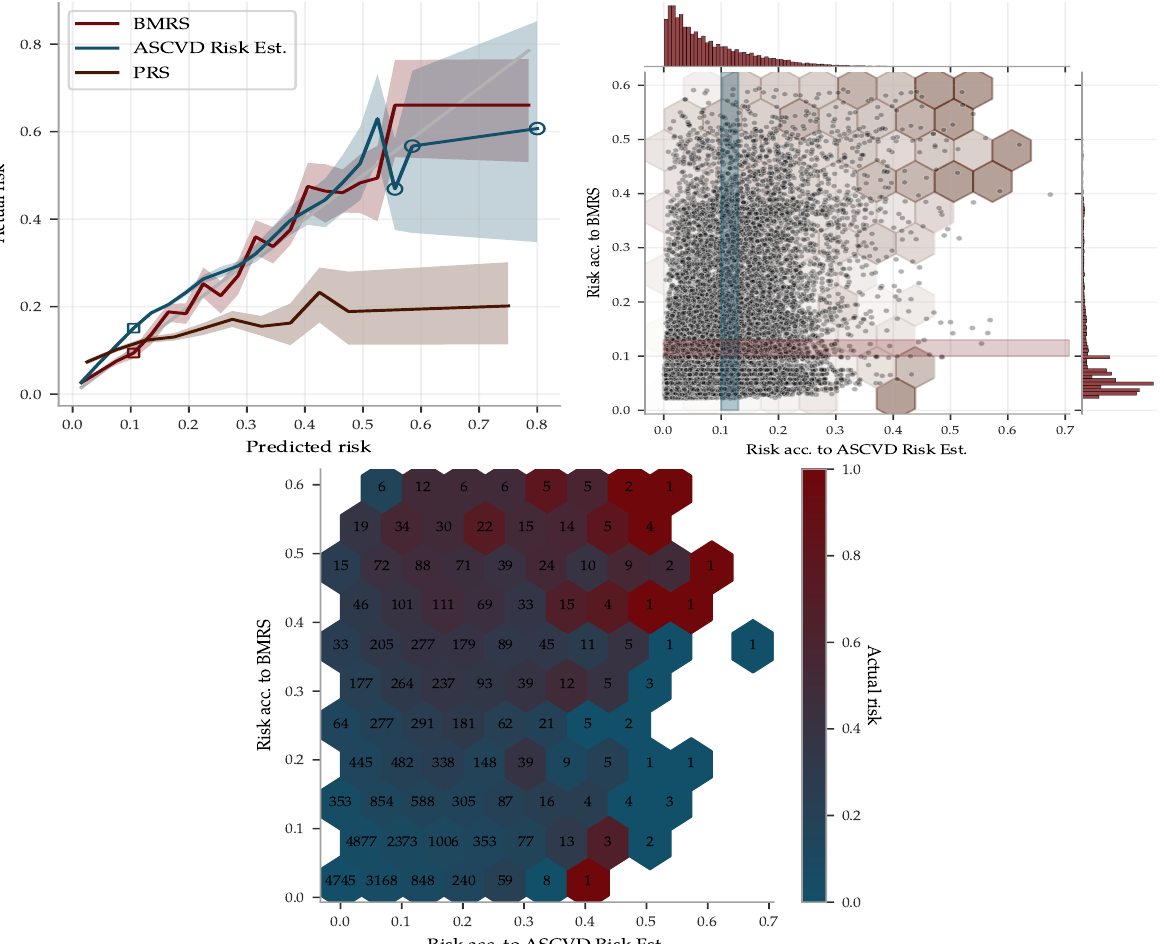
Figure 11. The ASCVD BMRS and the ASCVD Risk Estimator both make accurate risk predictions but with partially complementary information. ( Upper left ): Predicted risk by BMRS, the ASCVD Risk Estimator and a PRS predictor were binned and compared to the actual disease prevalence within each bin. The gray 1:1 line indicates perfect prediction. Shaded regions are 95% confidence intervals obtained from 100 fold bootstrap estimates of the prevalence in each bin (hollow circles indicate bin size < 50 samples). The ASCVD Risk Estimator was applied to 340k UKB samples while the others were applied to an evaluation set of 28k samples, all of European ancestry. ( Upper right ) shows a scatter plot and distributions of the risk predicted by BMRS versus the risk predicted by the ASCVD Risk Estimator for the 28k Europeans in the evaluation set. The BMRS distribution has a longer tail of high predicted risk, providing the tighter confidence interval in this region. The left plot y-axis is the actual prevalence within the horizontal and vertical cross-sections, as illustrated with the shaded bands corresponding to the hollow squares to the left. Notably, both predictors perform well despite the differences in assigned stratification. The hexagons are an overlay of the ( lower center ) heat map of actual risk within each bin (numbers are bin sizes). Both high risk edges have varying actual prevalence but with a very strong enrichment when the two predictors